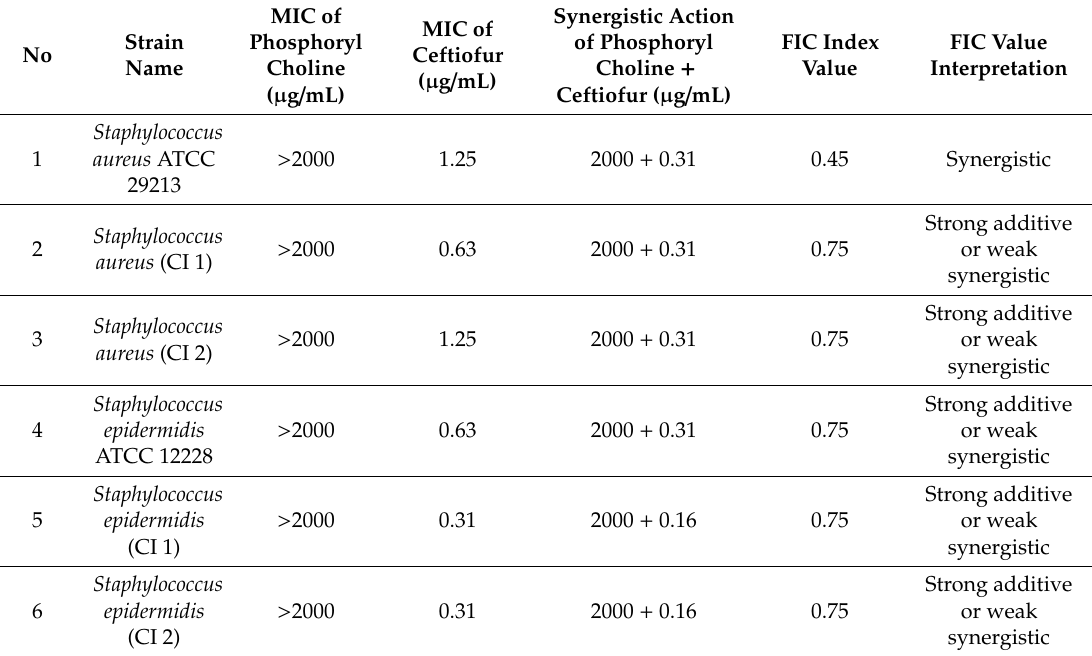
Table 2. Fractional inhibitory concentration (FIC) values for the combinations been tabulated above.